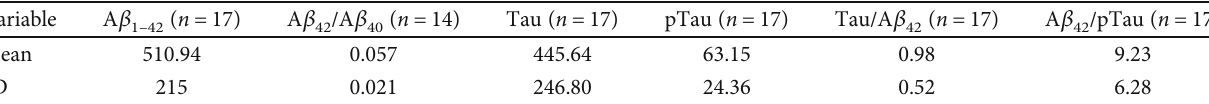
Table 1: AD patients ’ CSF biomarker